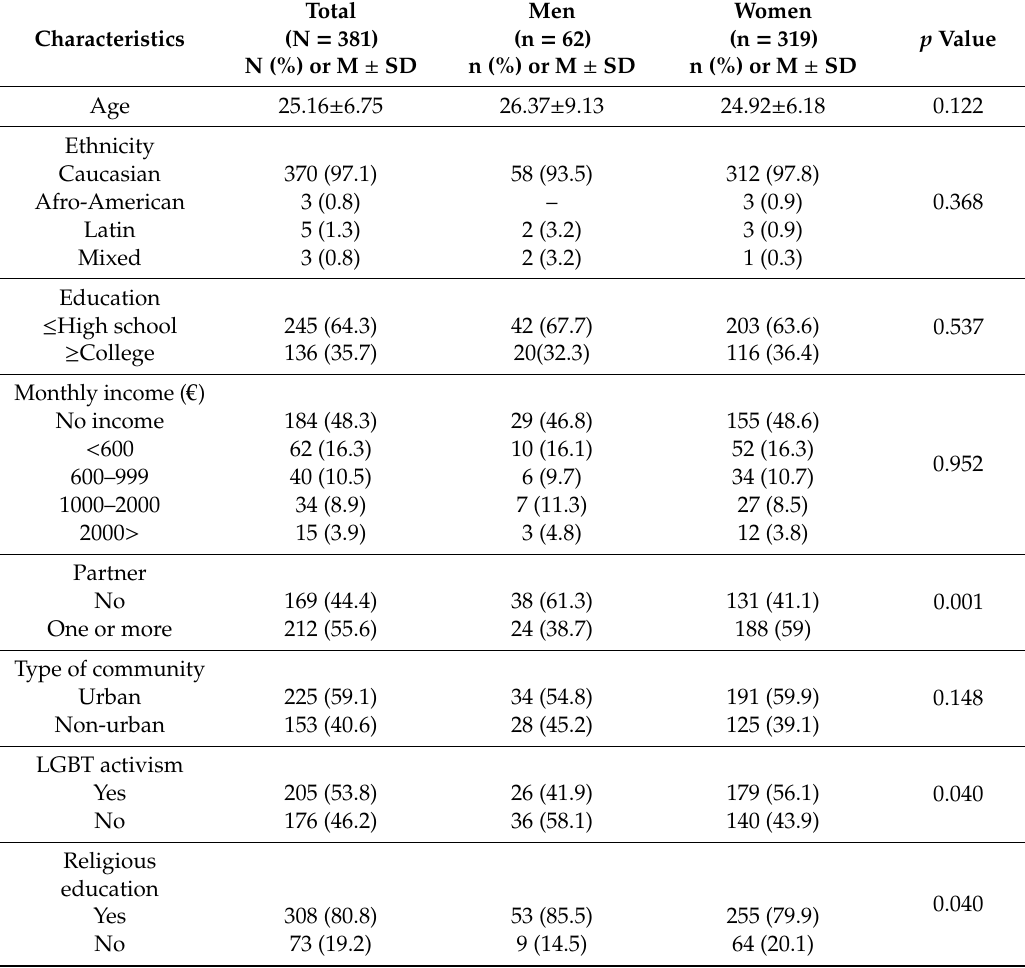
Table 1. Socio-demographic characteristics of participants (N =